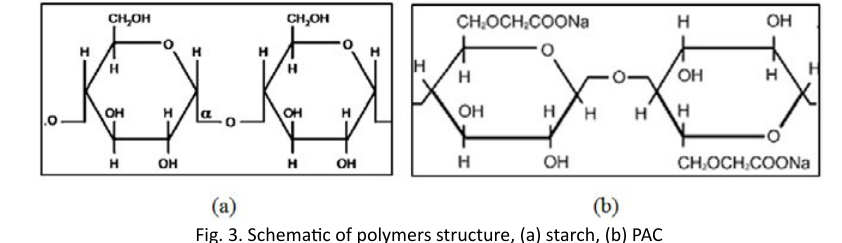
Fig. 3. Schematic of polymers structure, (a) starch, (b) PAC Table 1. BaSO nanoparticles size in different pH and polymers 4